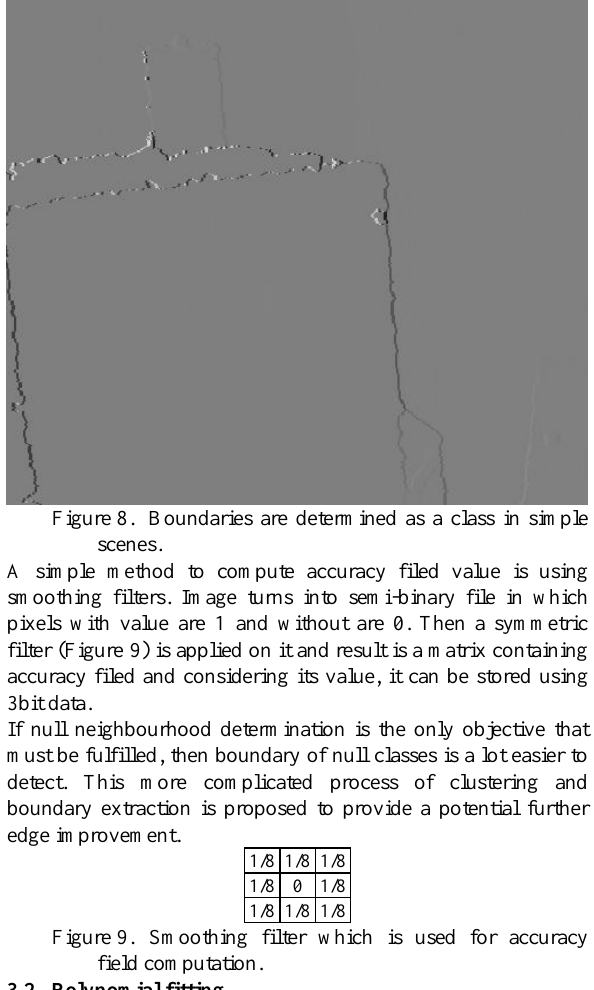
Figure 11. Specific areas are marked to be tracked and avoid confliction in point